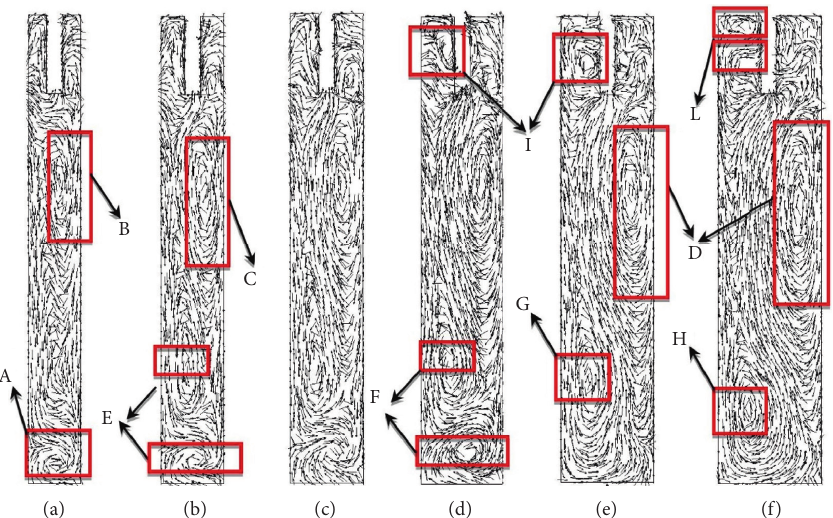
Figure 9: Separator flow field distribution at different cylinder diameters. (a) d d sep � 16mm. (e) d sep � 18mm. (f) d sep �